Question: What does this figure show? Answer in one sentence.
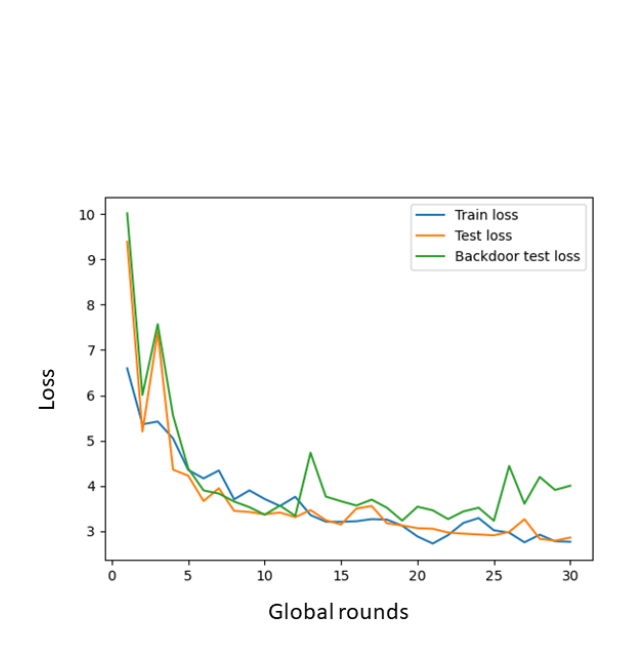
Answer: Loss trajectories for a successful targeted attack (OTA) against LFR defense.